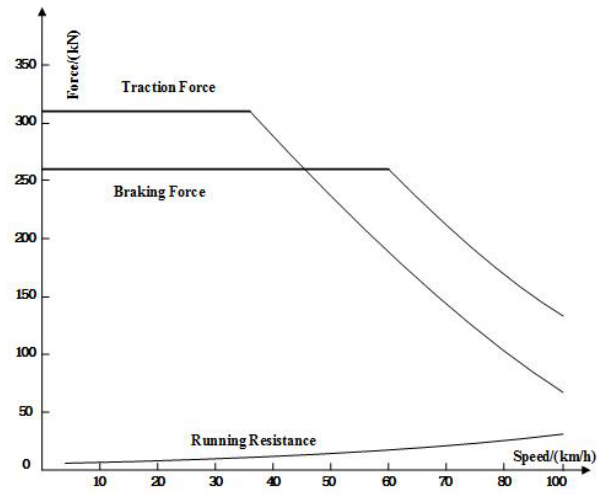
Figure 10. The profile of traction force, braking force and basic resistance force.